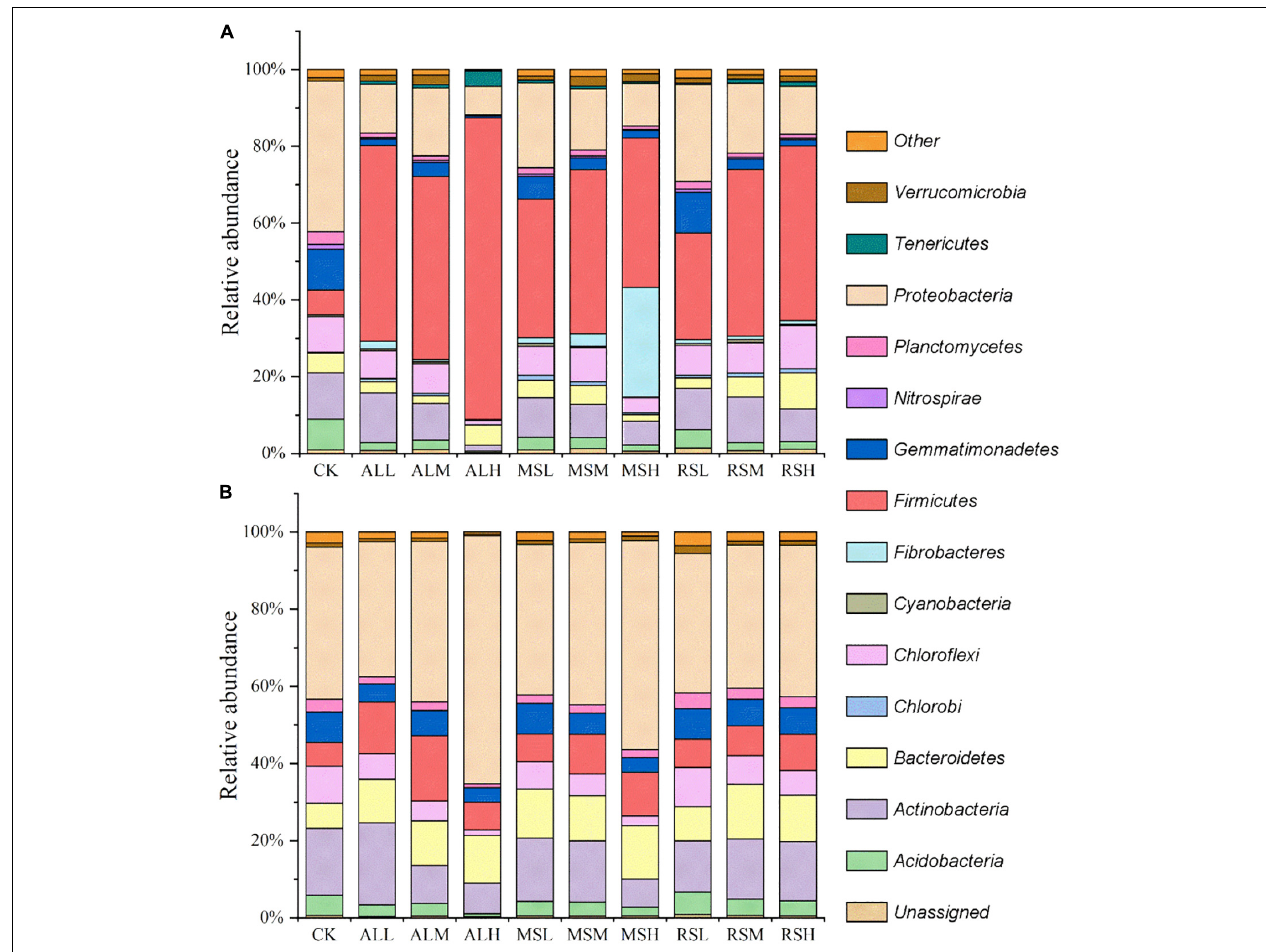
FIGURE 3 | Relative abundances (%) of individual taxonomic groups of the bacterial phyla present in samples from the 10 treatments. (A,B) Day 21 and after tomato planting, respectively. Bacterial phyla with relative abundances lower than 1% in all the treatments were clustered as